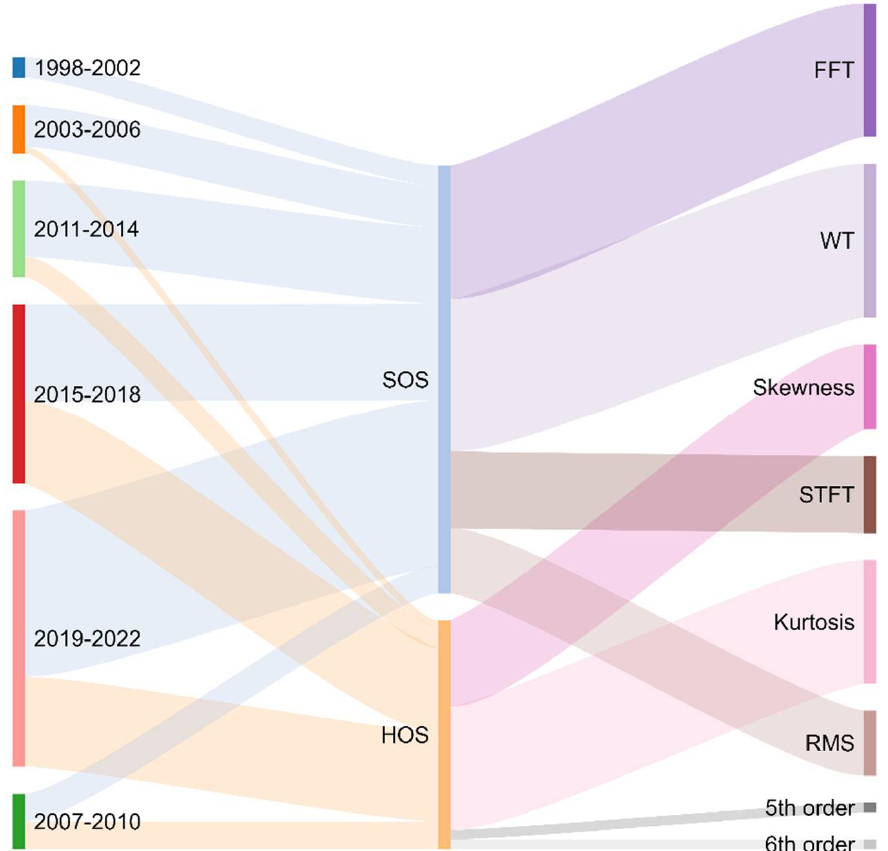
Figure 6. Parallel set that relates the year of publication of the paper with the type of statistic em- ployed and